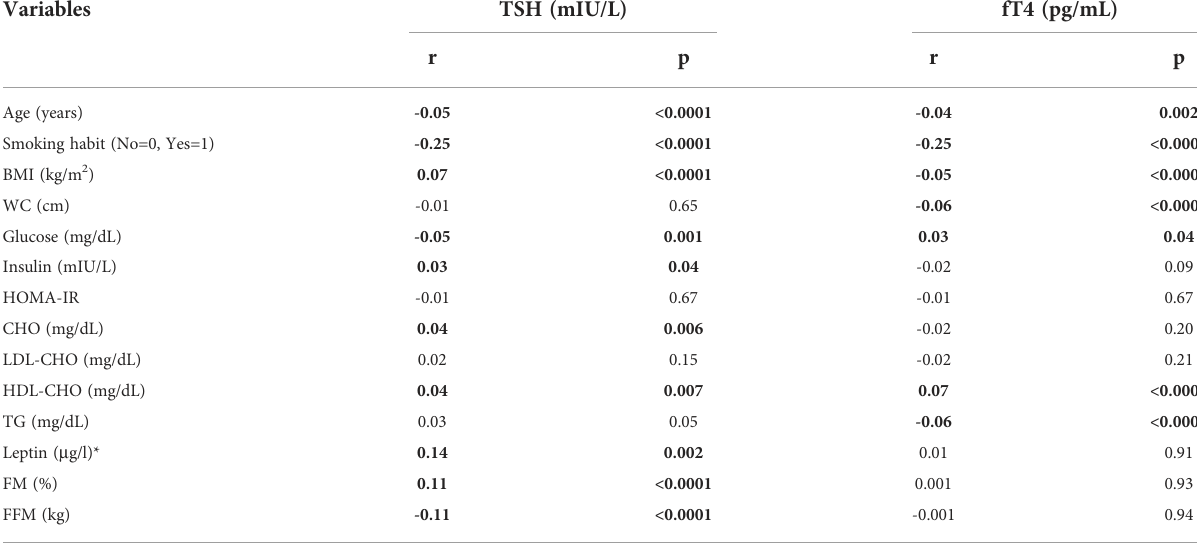
TABLE 3 Bivariate correlation analysis between serum TSH or fT4 levels and demographic, anthropometric, biochemical and metabolic variables.